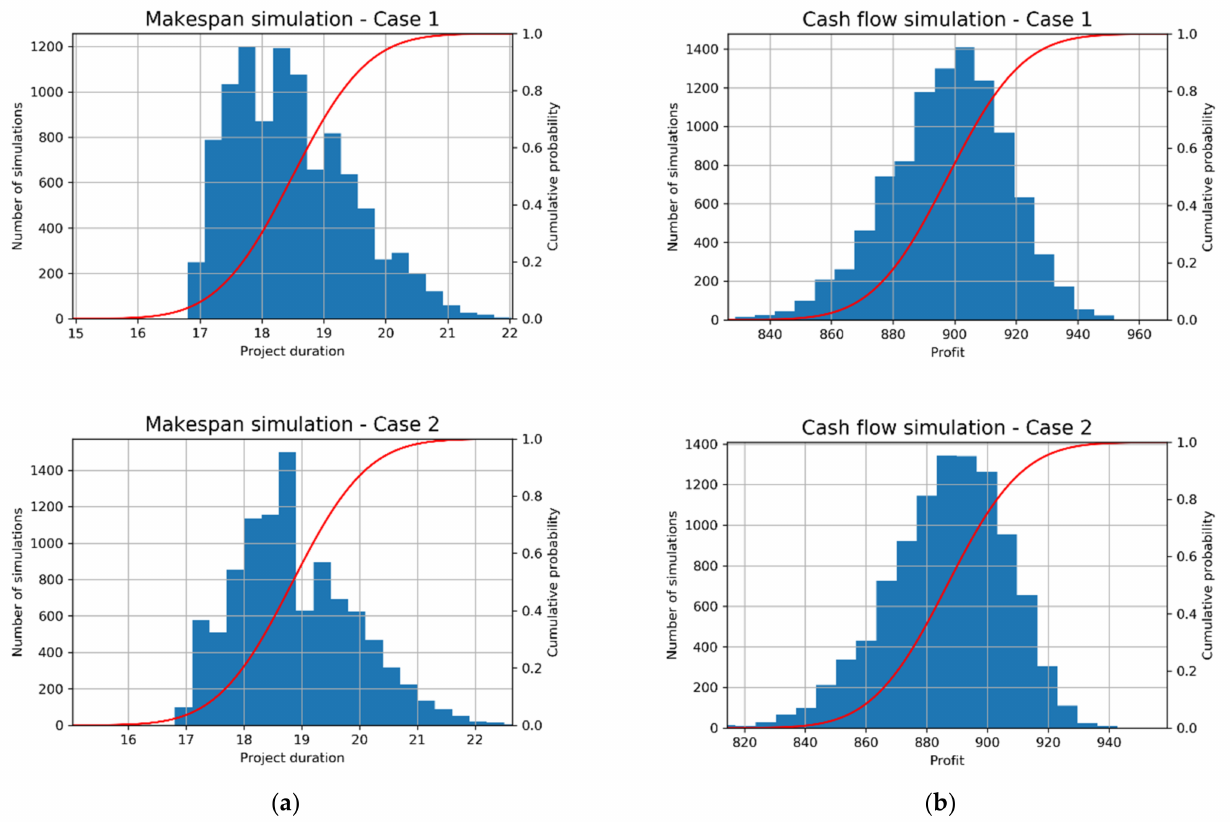
Figure 5. Simulation results: ( a ) total project duration (months); ( b ) total project profit for all iterations in simulation, CL may be broken (thousand of financing